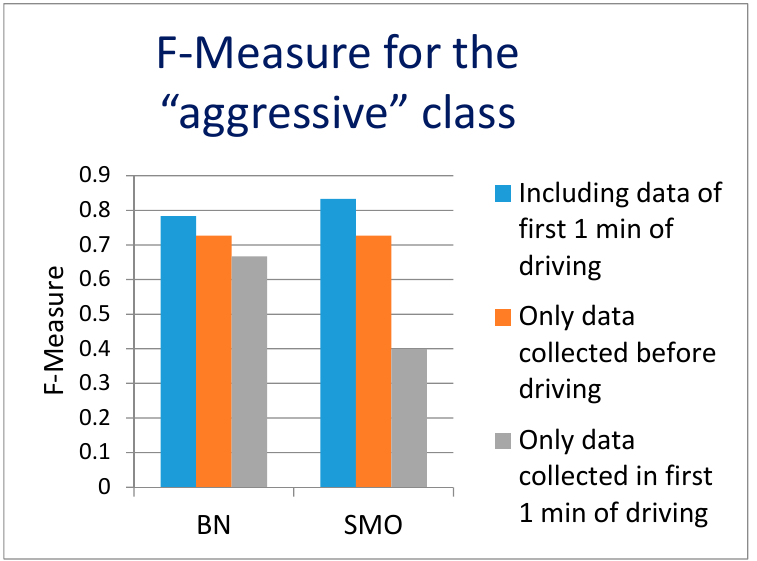
Figure 6. The F-Measure of the classification aggressive driving (“a” class) for the data collected before the driving and for the data collected before and during the first 1 min of the driving.